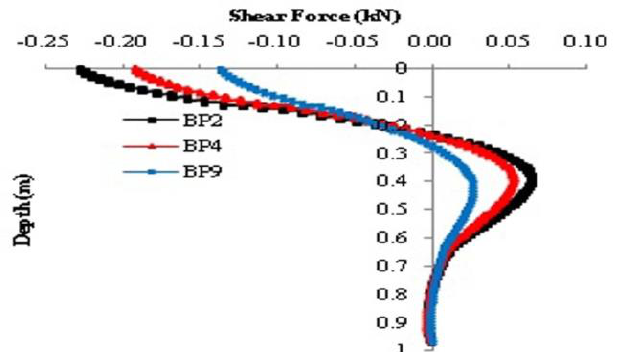
Fig. 18. Predicted different pile group shear force results at 3D pile spacing of bamboo pipe piles in loose layer in-between dense layers for slenderness ratio as 38.